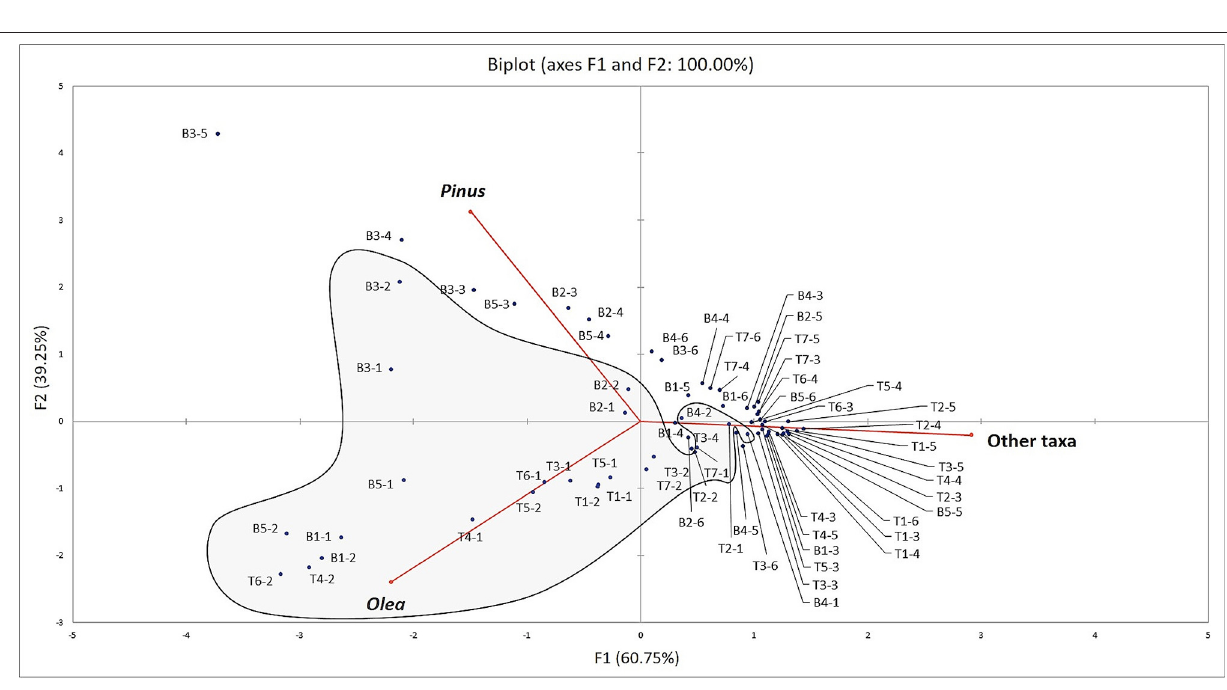
FIGURE 5 | Principal component analysis (PCA; elaboration: XLSTAT 2014) for the 70 samples from the 12 studied olive groves. The modern pollen spectra shows that the percentage of Olea depends on the distance from the olive groves (sector III), and on the presence of Pinus (II) or other taxa (IV,